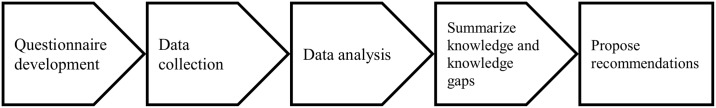
Overall study flow.